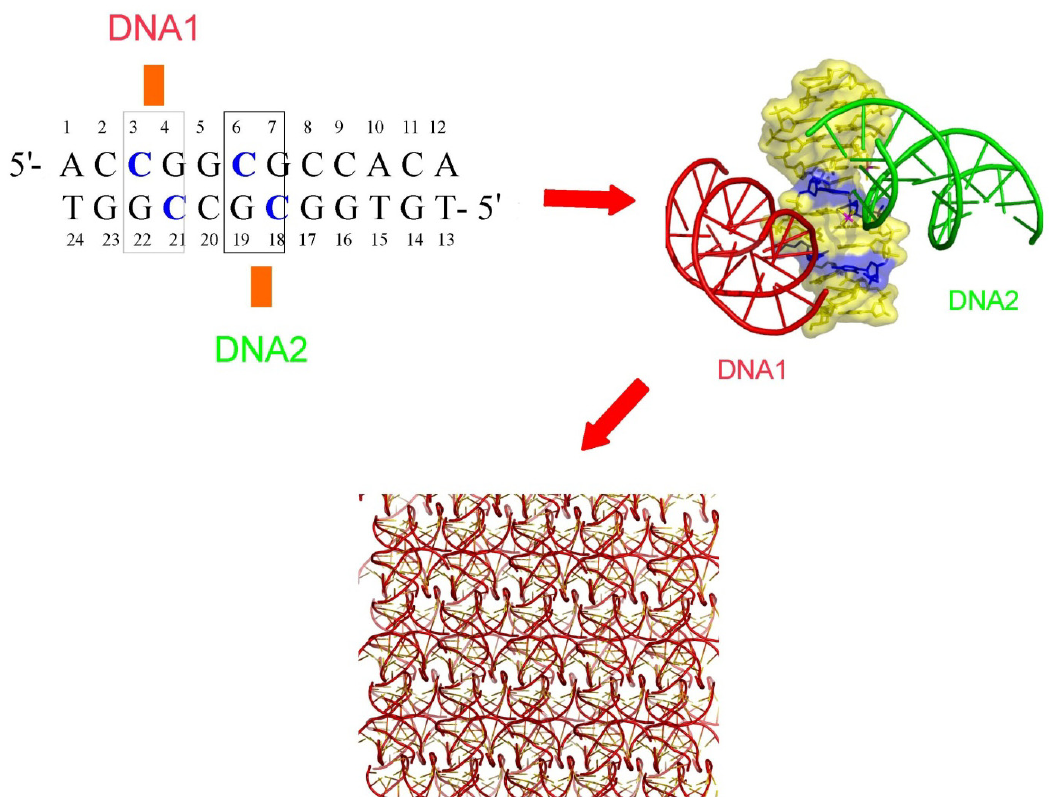
Figure 2. Design of crystal lattice from DNA sequence. The cytosines (represented in blue) along the duplex sequence define the anchoring points for groove-backbone interaction. The crossing of the duplexes within the crystal lattice is therefore controlled by the DNA